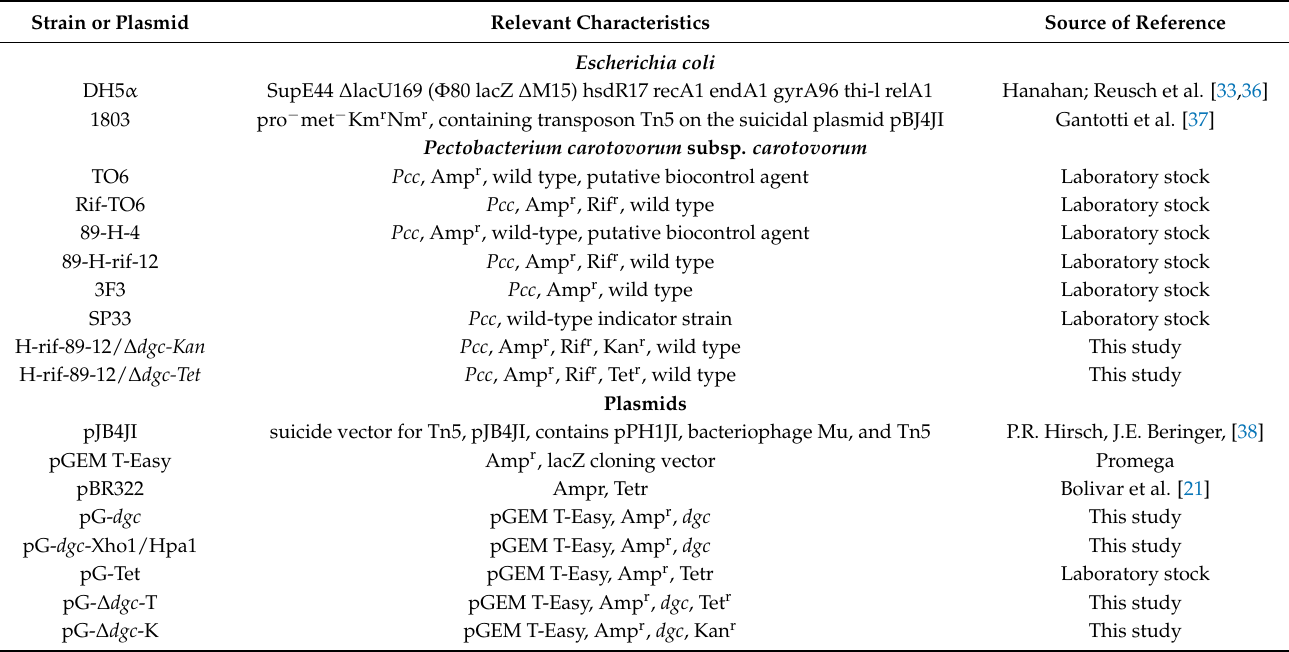
Table 2. Bacteria and plasmids used in this